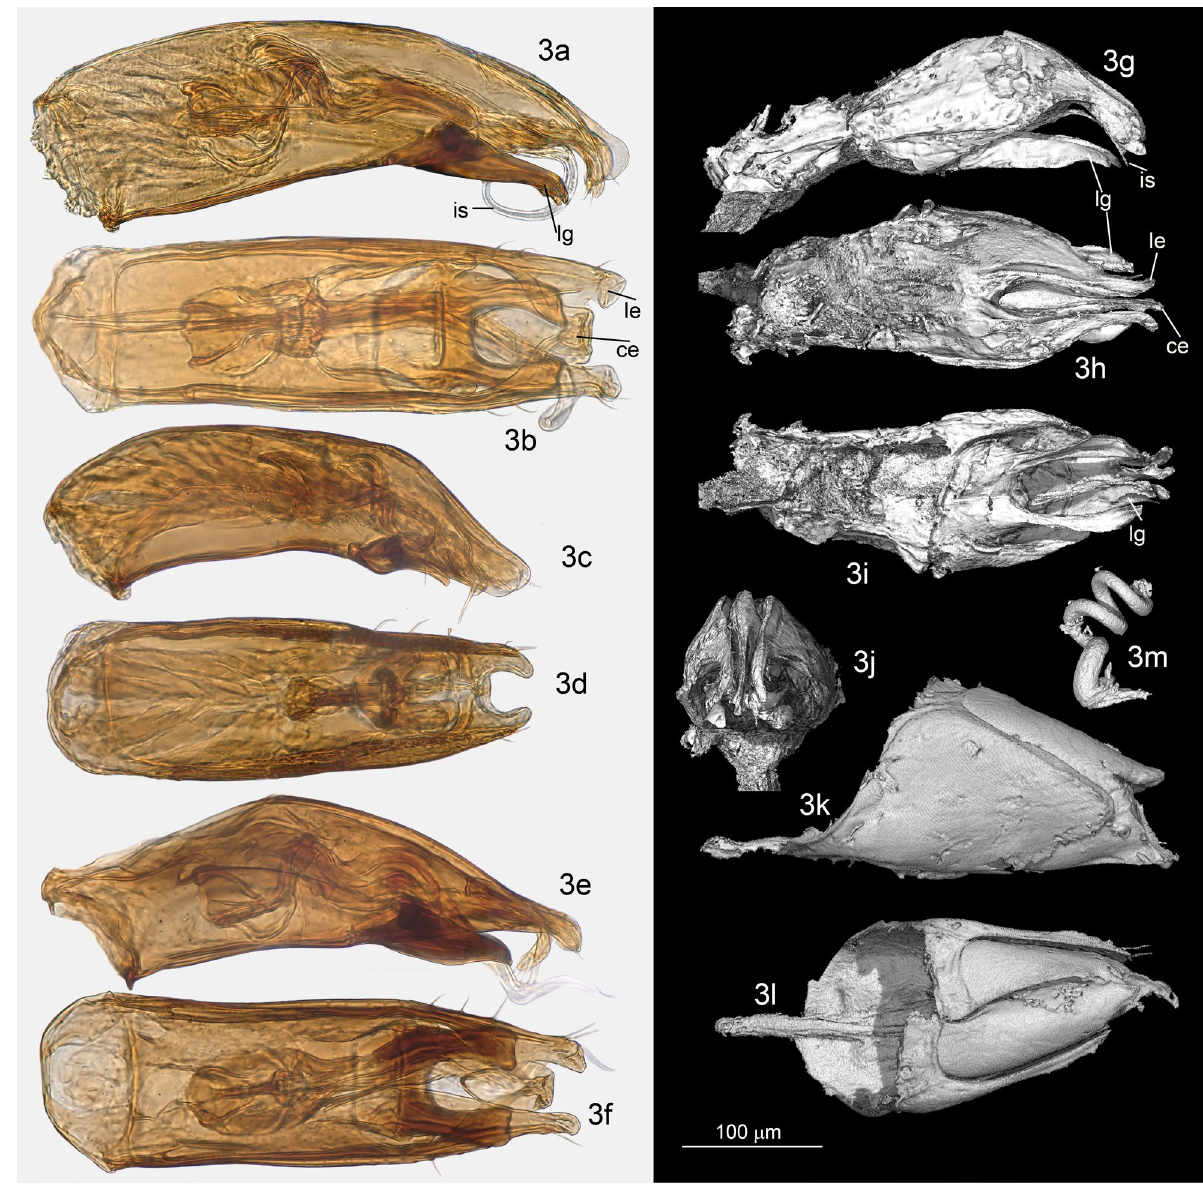
Figure 3. Genus Proptomaphaginus , genital structures. ( a ) P. hispaniolensis , aedeagus left lateral view. ( b ) P. hispaniolensis , aedeagus dorsal view. ( c ) P. puertoricensis , aedeagus left lateral view. ( d ) P. puertoricensis , aedeagus dorsal view. ( e ) P. apodemus , aedeagus, left lateral view. ( f ) P. apodemus , aedeagus, dorsal view. ( g ) † P. alleni , aedeagus left lateral side. ( h ) † P. alleni , aedeagus dorsal view. ( i ) † P. alleni , aedeagus ventral view. ( j ) † P. alleni , aedeagus frontal view. ( k ) † P. alleni , male genital segment lateral view. ( l ) † P. alleni , male genital segment dorsal view. ( m ) † P. alleni (specimen MP033), wide base of spermaduct. Abbreviations: ce = central expansion, is = internal stylus, le = lateral expansion, lg =